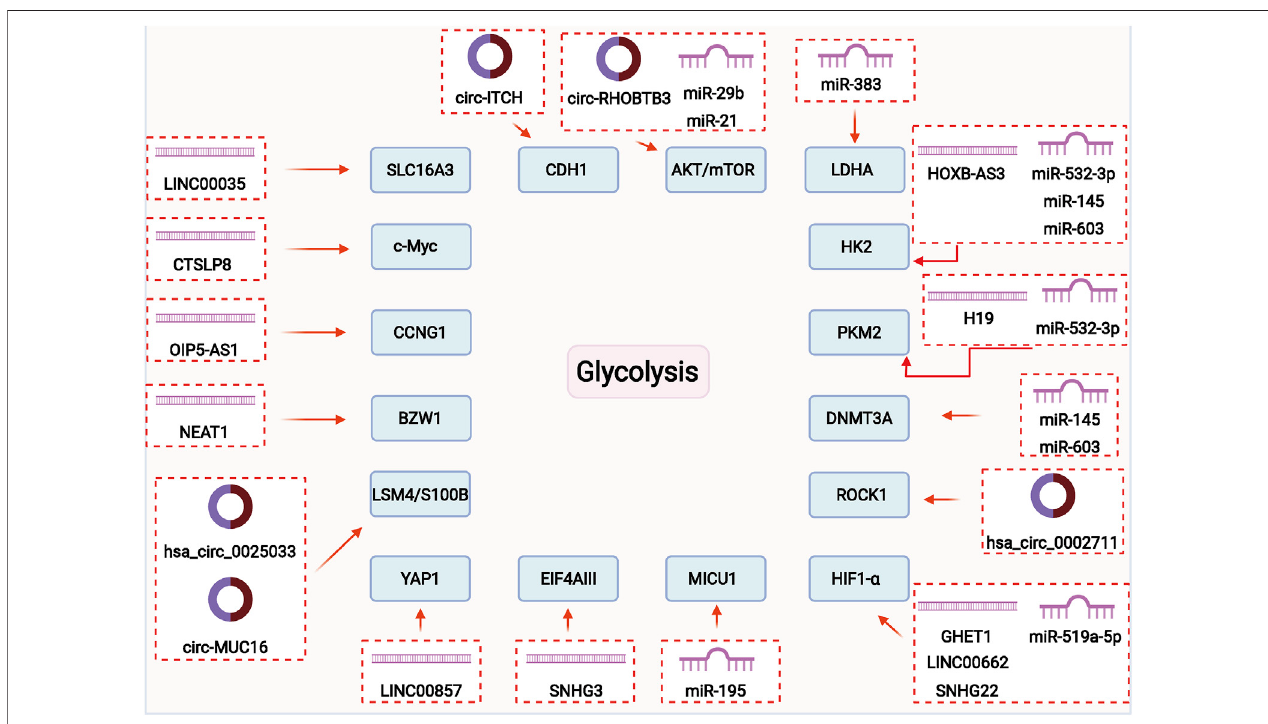
FIGURE 2 | ncRNAs may play a vital role in regulating glycolysis of ovarian cancer through different signal pathways and mechanisms.